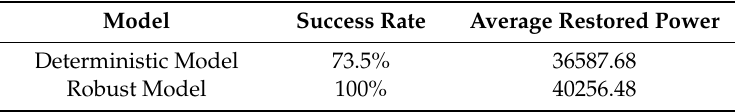
Table 12. Results of restoration using Monte Carlo